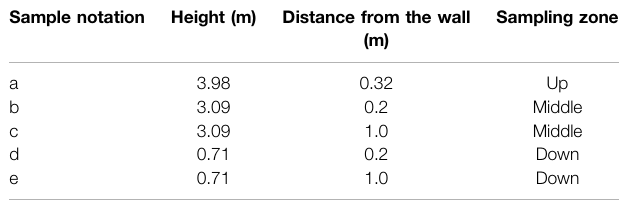
TABLE 1 | The con fi guration of the sample